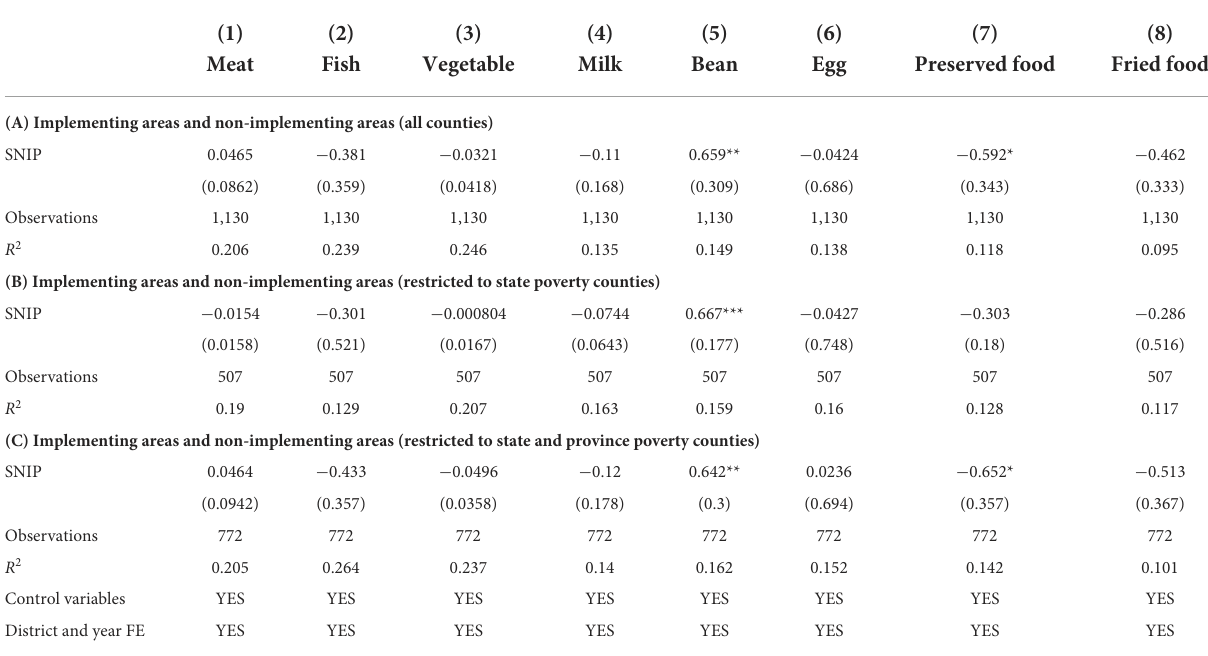
TABLE 6 Nutrition diversity.